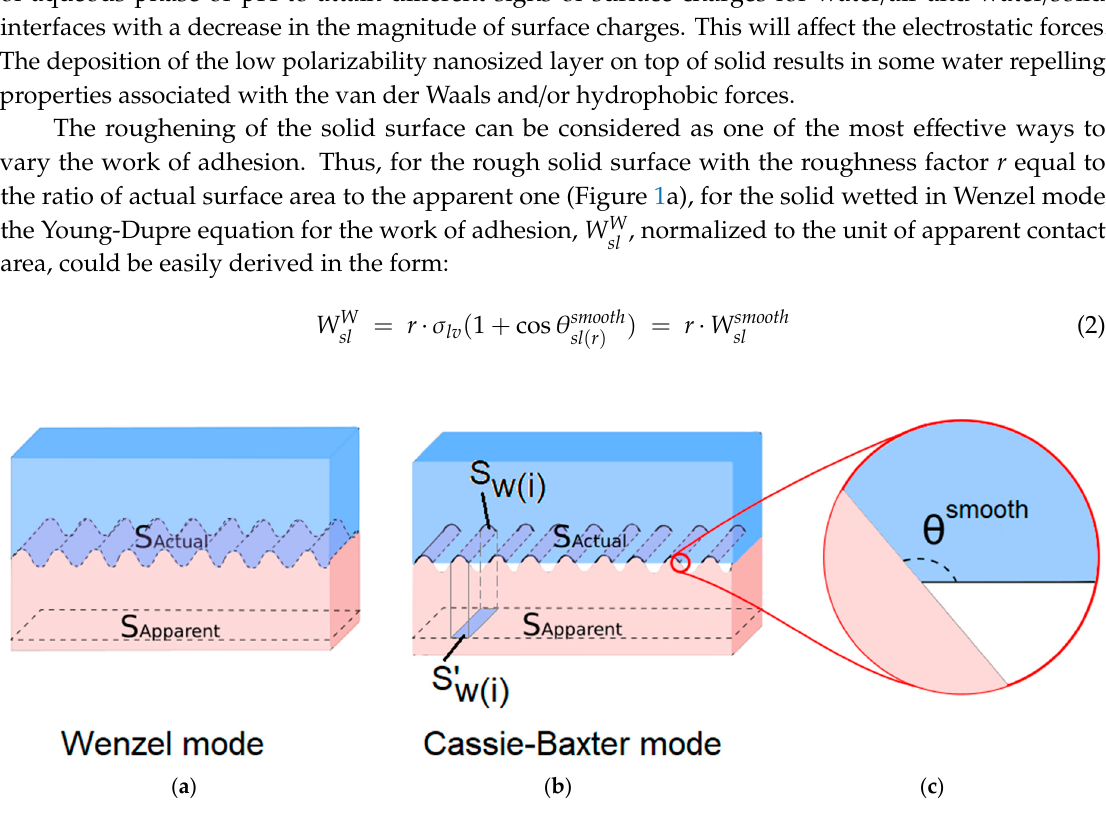
Figure 1. Schematic representation of wetting of the rough substrate in different modes explaining some definitions. ( a ) In a homogeneous (Wenzel) wetting mode the liquid fills all the depressions (grooves) of the surface relief; the roughness factor is determined as the ratio of actual and apparent (projected) surface areas; ( b ) In the heterogeneous (Cassie ‐ Baxter) wetting mode air inclusions remain between the liquid and the solid surfaces; two factors are essential to describe this wetting mode, the fraction of apparent area directly contacting with the liquid, and the roughness factor of that wetted area; ( c ) At the equilibrium, the local contact angle at the groove wall is equal to one defined by the Young equation for the flat smooth surface with the same chemistry.